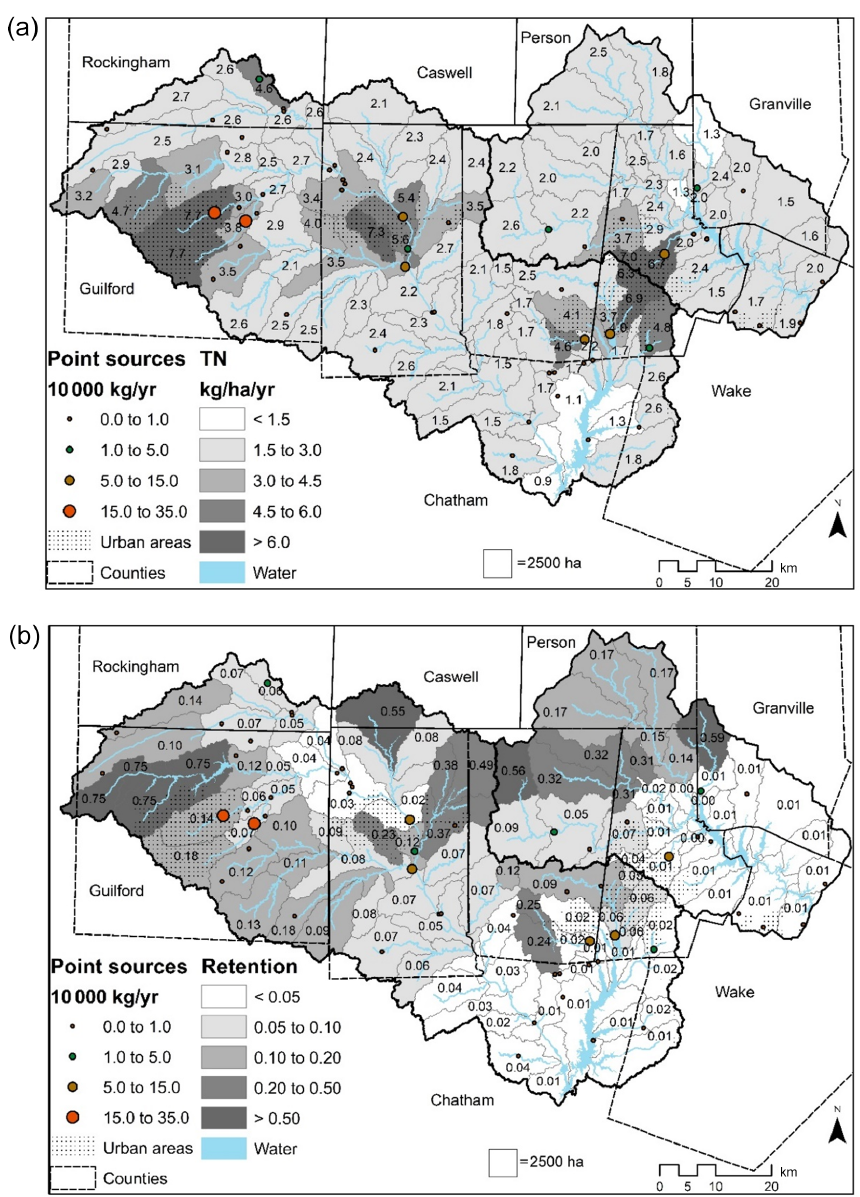
Figure 5. TN export (a) from land use and livestock by subwatershed; fraction of TN export from each subwatershed that is retained (b) in streams and reservoirs prior to reaching Jordan and Falls Lakes. Point source loads are shown separately as